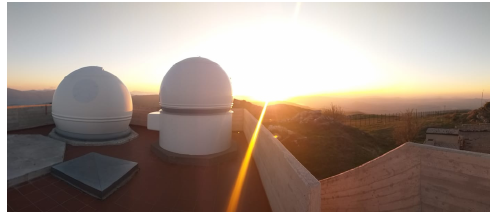
Figure 2. The sunset over KIAM / GAUSS Srl joint observatory in Castelgrande, Italy